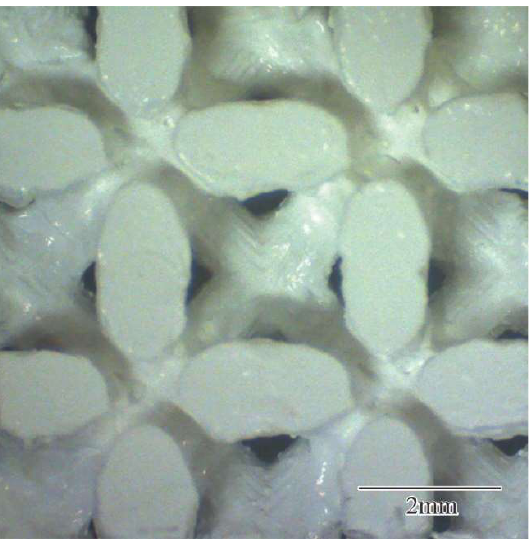
Figure 10. The acryl microlattices with the YSZ nanoparticles. The structure will be transferred into a dendritic electrode. The stereolithographic additive manufacturing (STL-AM) components were heat-treated at 1400 °C for 2 h in air. The 12-coordinated lattices were processed at a dimensional accuracy of ±10 µm.